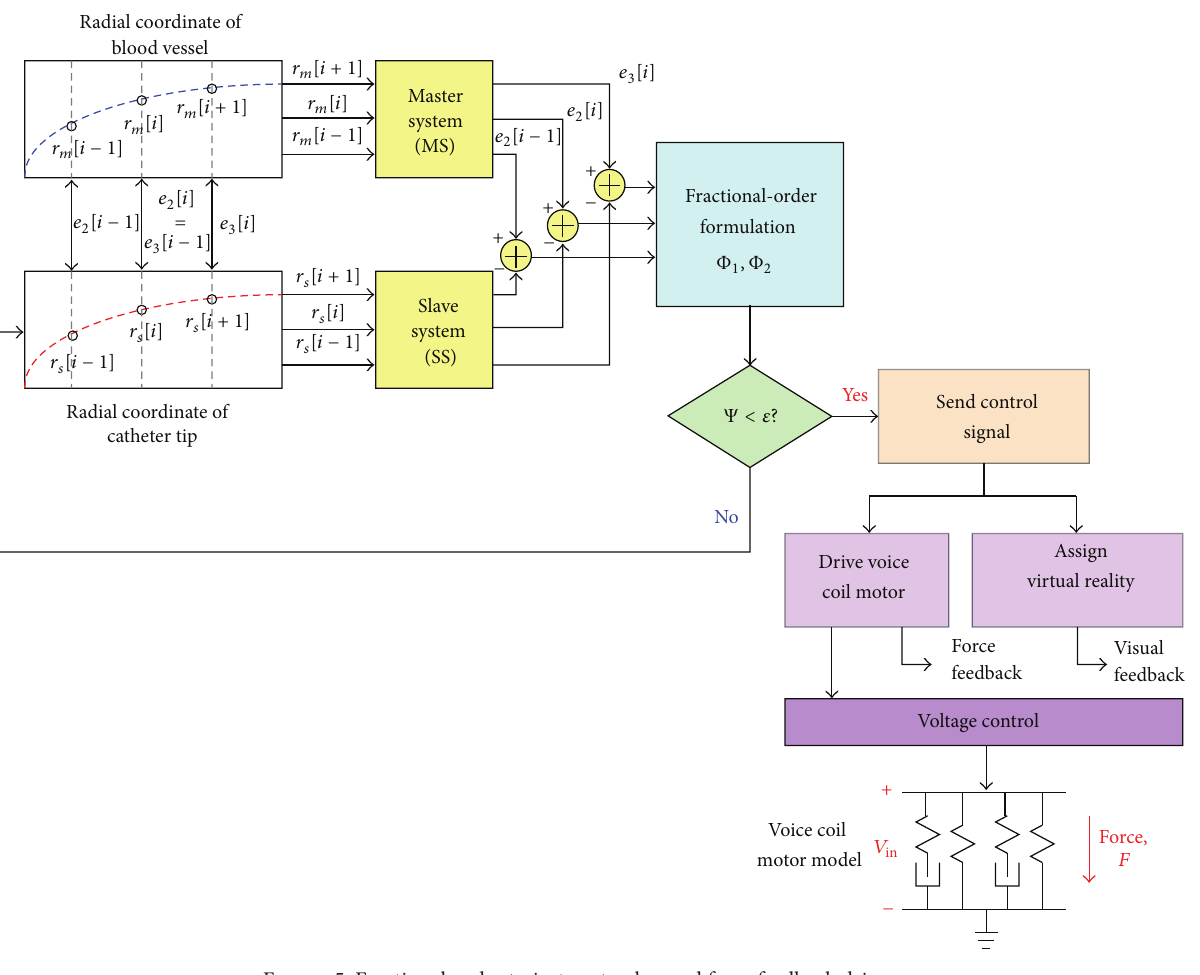
Figure 5: Fractional-order trajectory tracker and force feedback